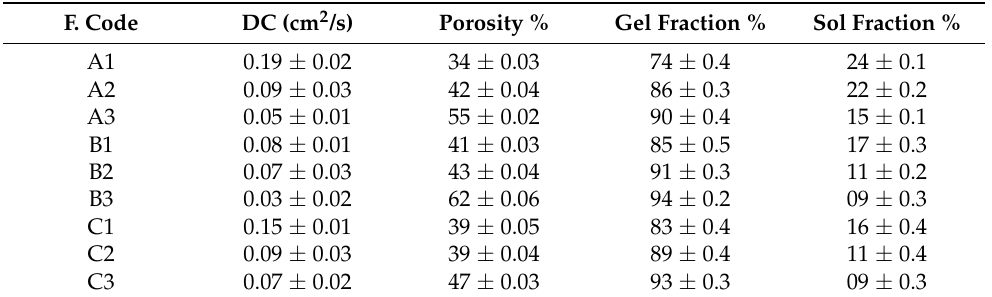
Table 3. Diffusion coefficient, porosity %, gel fraction %, and sol fraction % of formulated 5-FULH. F. Code